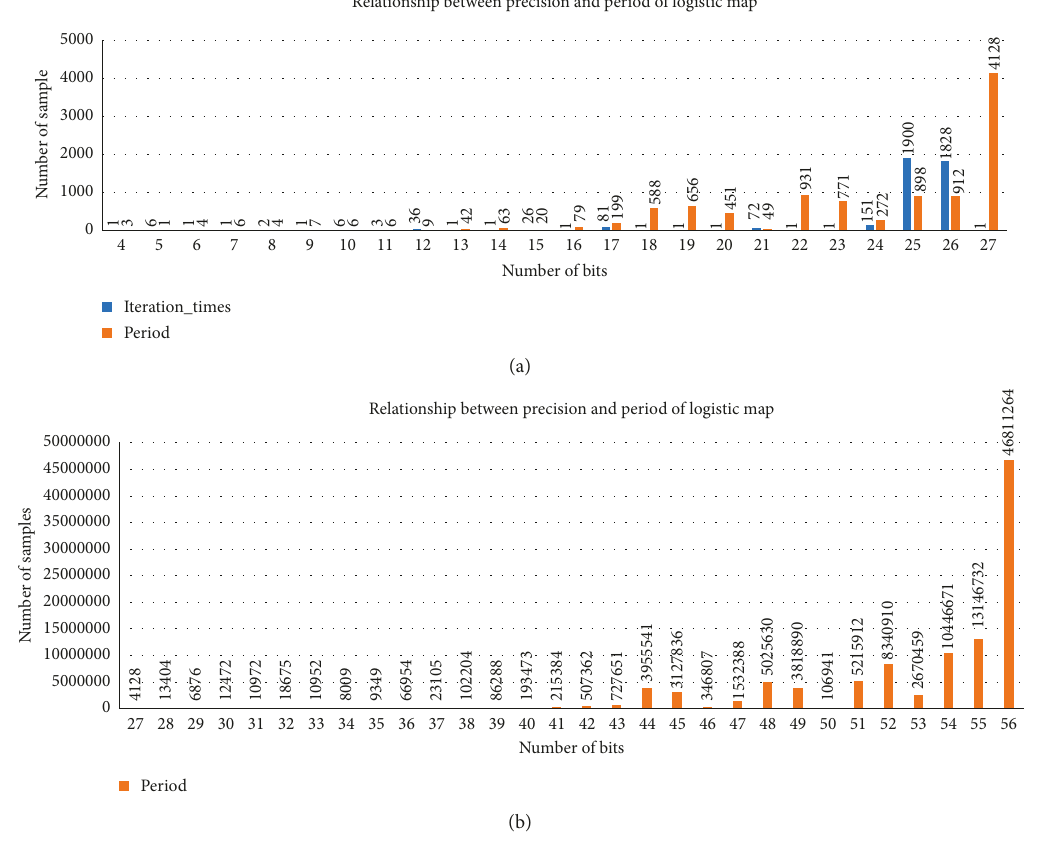
Figure 5: Relationship between precision and period of the logistic map. (a) 27-bits. (b) 27-bits to 56-bits.